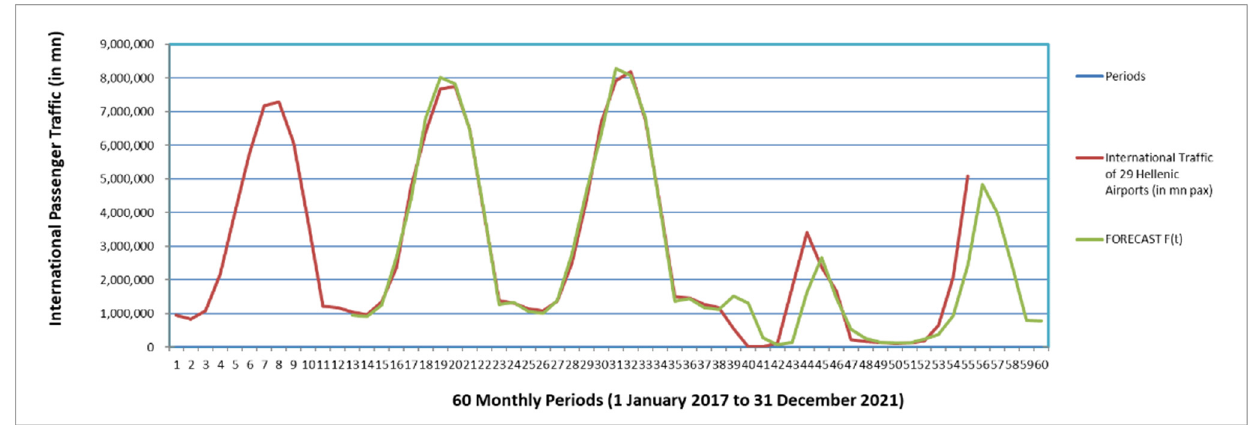
Figure 3. Model fitting and forecast for international pax air traffic in Greece.